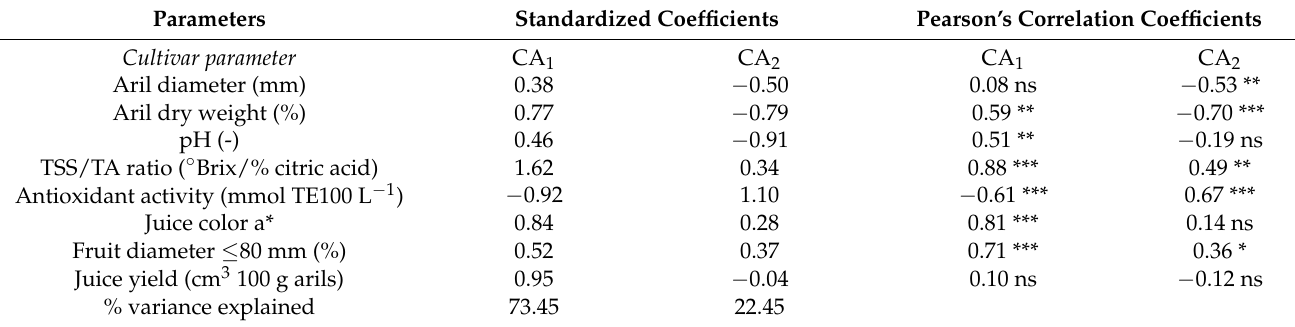
Table 6. Standardized coefficients (scores) and Pearson’s correlation coefficient for the first two canonical axes (CA 1-2 ), considering the different morpho-qualitative parameters as selected